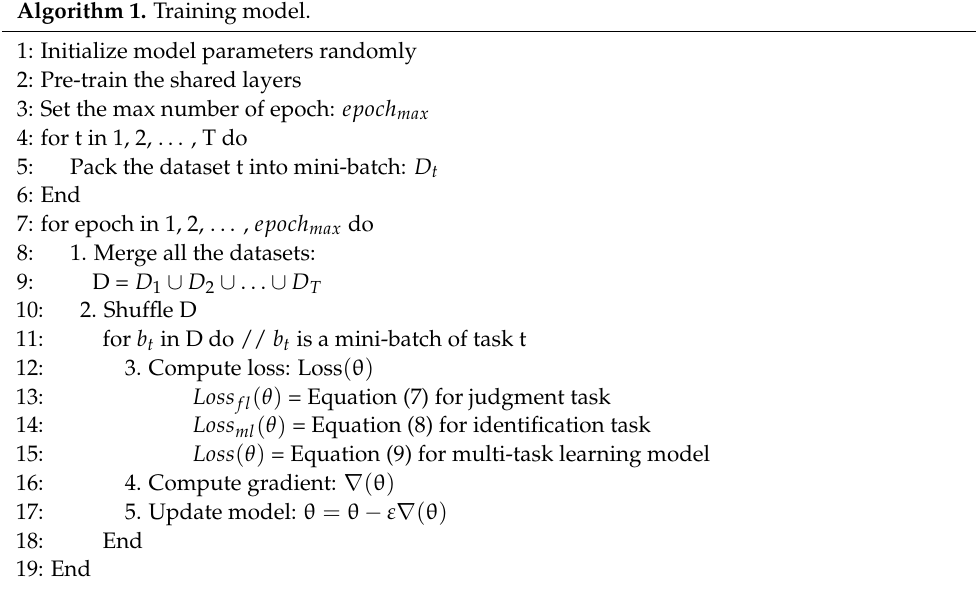
Algorithm 1. Training